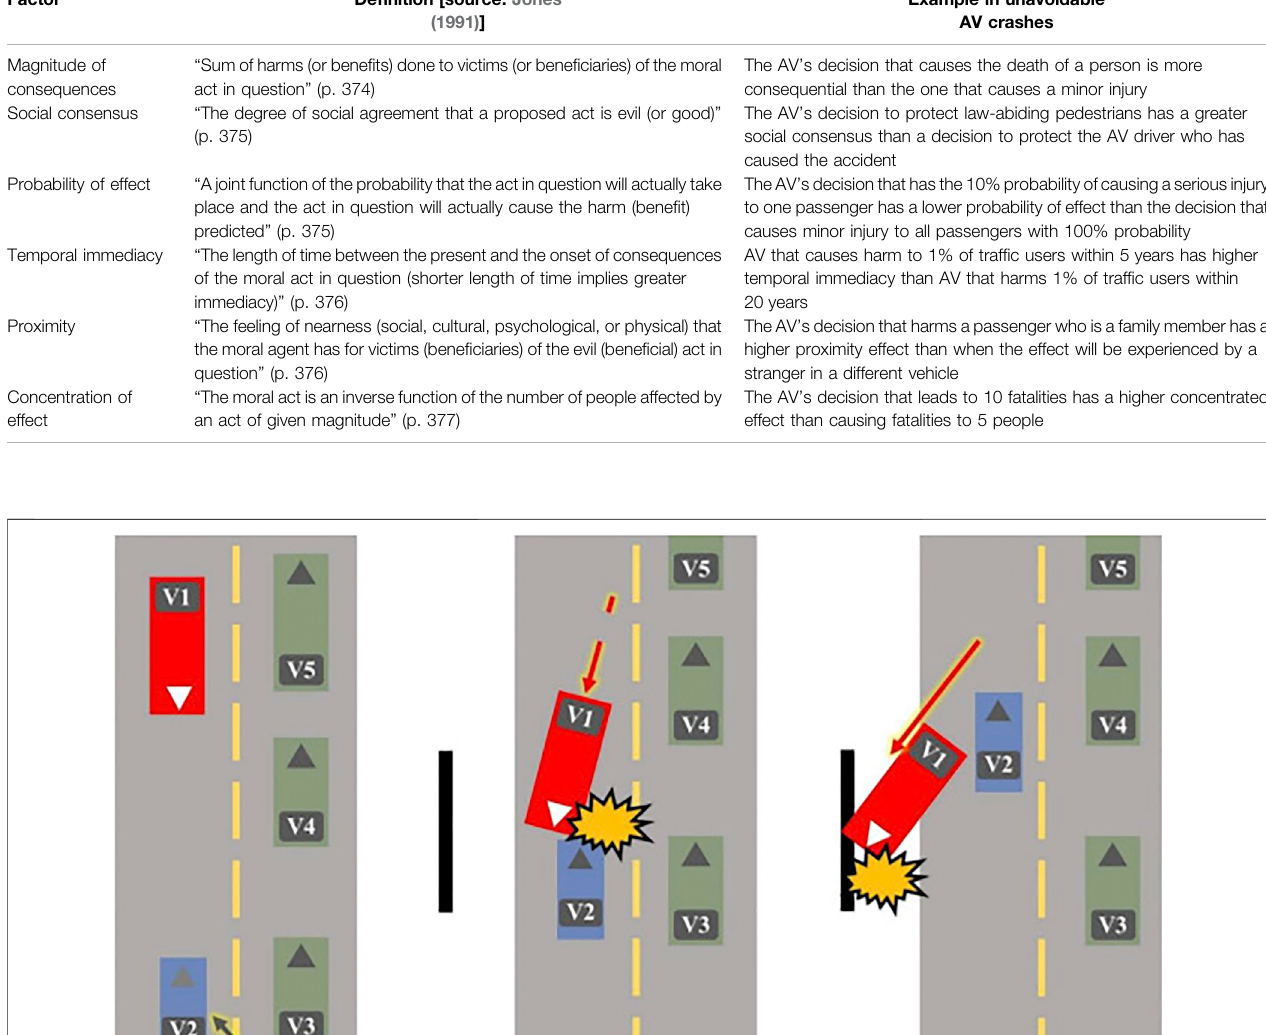
Example in unavoidable AV crashes